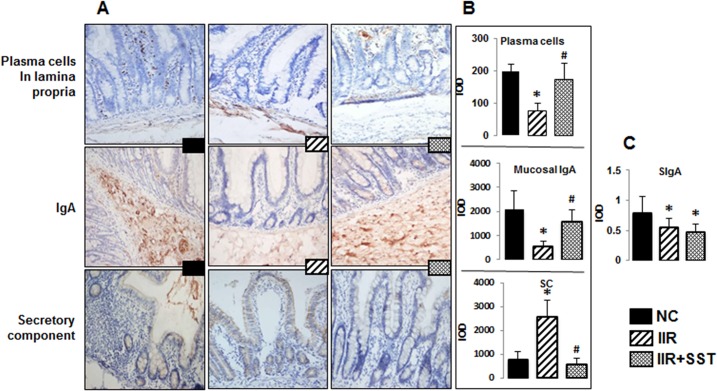
Humoral immune response of B cells in three groups.A) Location of plasma cells, IgA and secretory components in the terminal ileum of three groups. (Immunohistochemical staining, × 200 magnification). B) Semi-quantitative analysis of the plasma cells in the lamina propria, IgA in the submucosal area and secretory component (SC) in the intestinal lumen by integrated optical density (IOD) in the three groups. C) SIgA levels in the ileac mucosa measured by ELISA. Data were showed as the mean ± SD of 5 animals per group. *, compared with the NC group, P<0.05. #, compared with the IIR group, P<0.05.